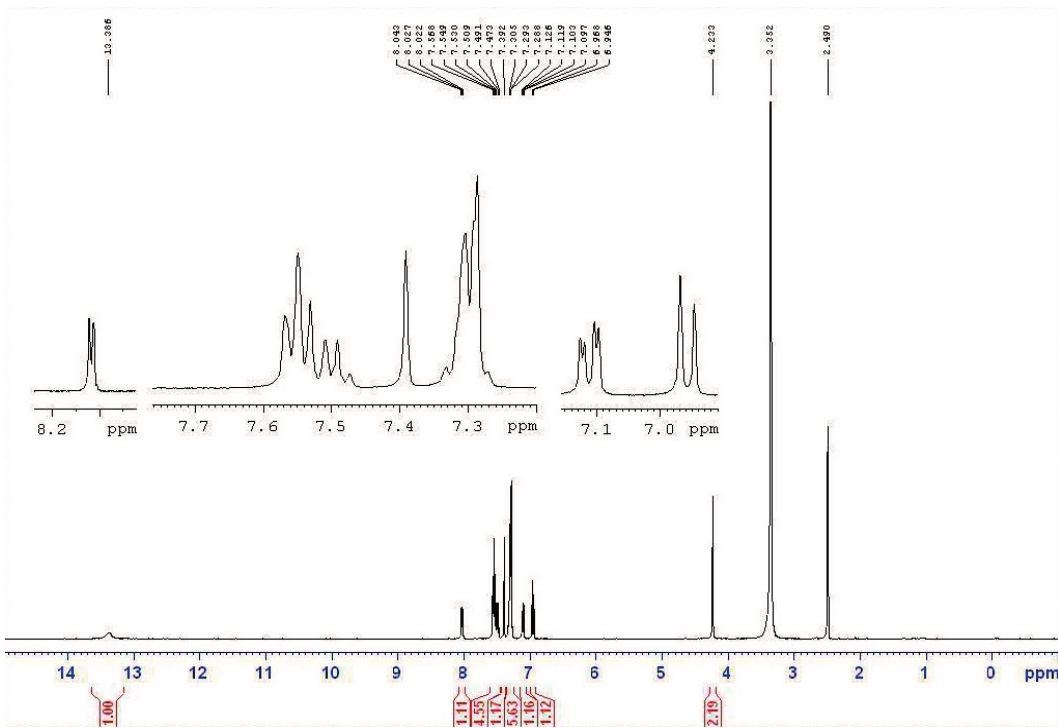
Figure 4. The NMR spectrum of nickel complex 16a derived from semicarbazone 13a